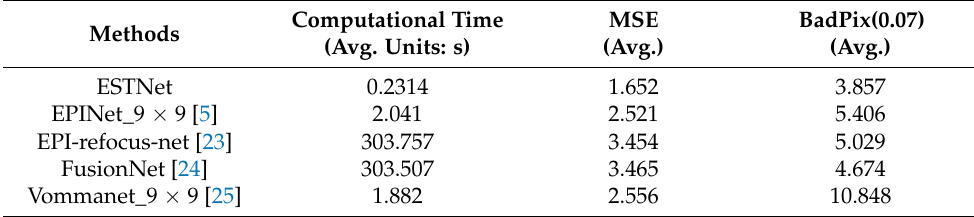
Figure 6. Examples of BadPix results for each network. Table 5. Performance comparison of current popular neural networks.